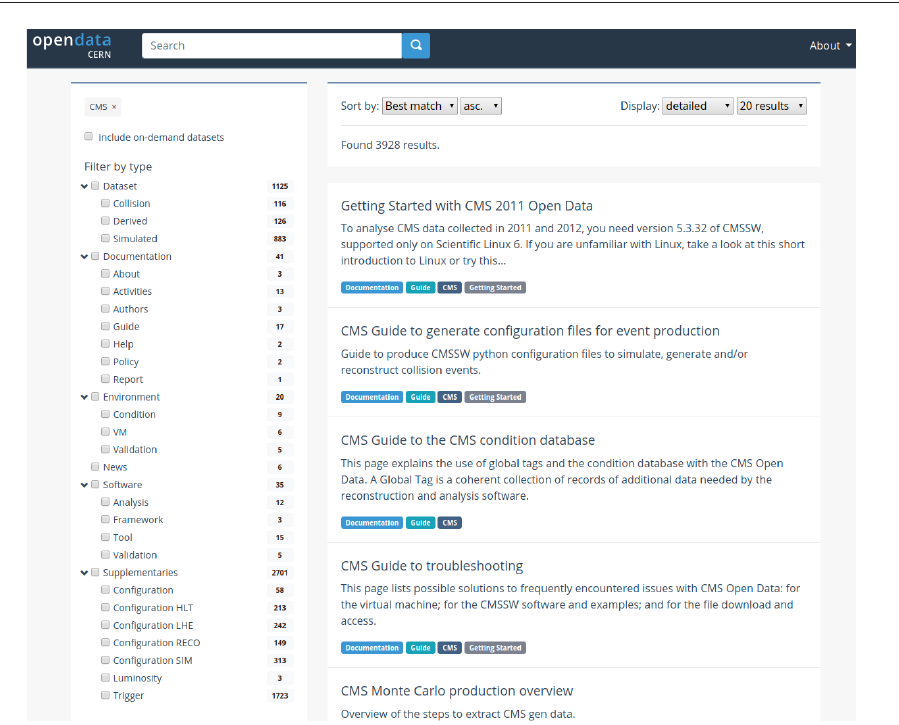
Figure 1. The richness of the CMS collections on the CERN Open Data portal. Note the search facets on the left indicating collision, derived and simulated datasets, various kinds of documentation, the computing environment and virtual machines, the software tools and example analyses, up to various kinds of supplementary material and configuration